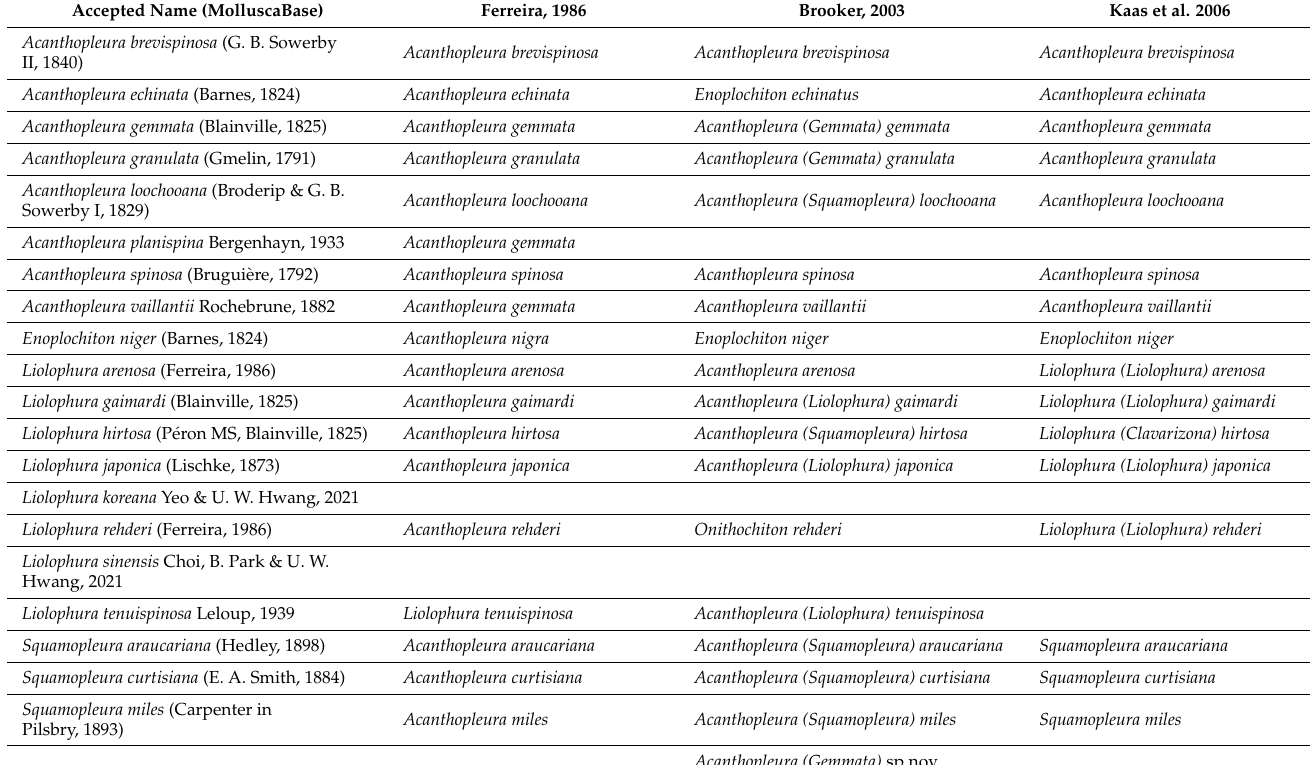
Table 1. Species belonging to the subfamily Acanthopleurinae have been identified in different